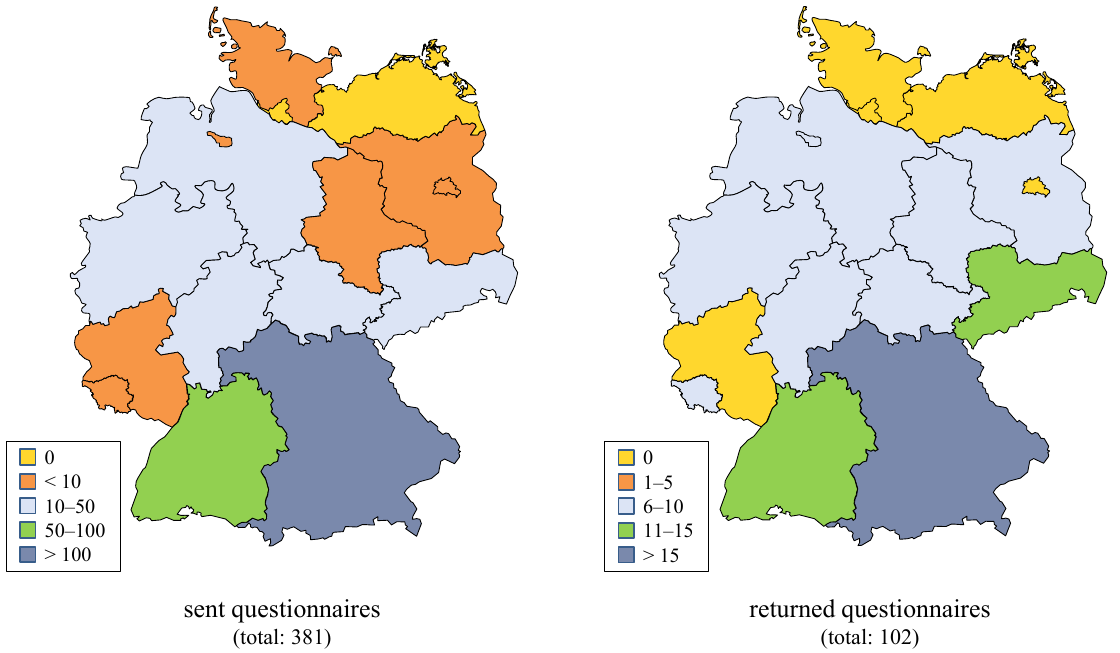
Figure 1. Distribution of questionnaires sent ( left ) and returned ( right ) by the 16 federal states of Germany.